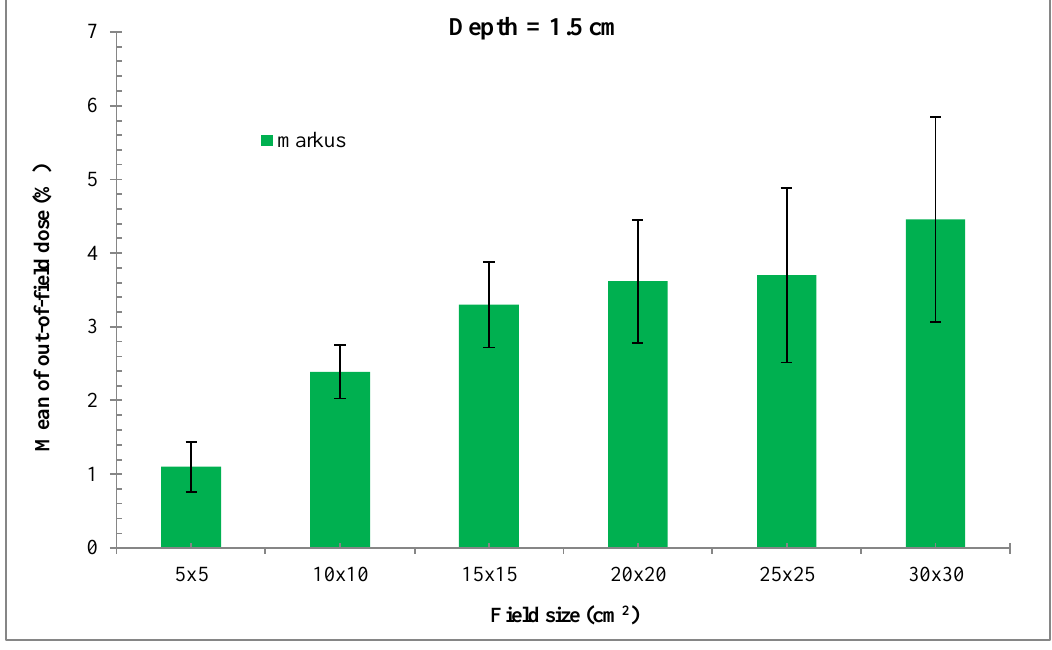
Figure 2.Variation of mean out-of-field dose with different field sizes using Markus ionization chamber detectors. The error bars represent the standard deviation